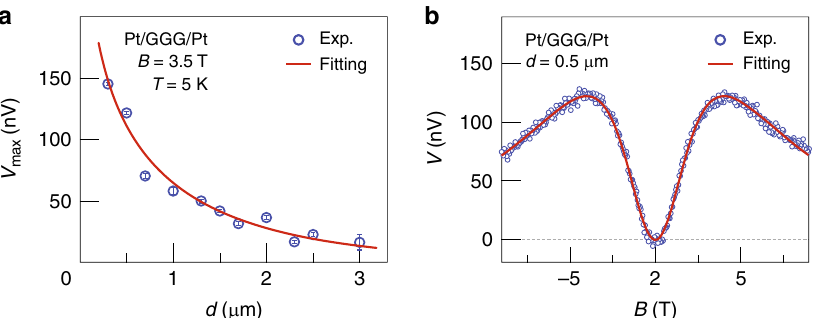
Fig. 4 Comparison with theory. a The experimental results (blue circles) and calculations (solid red line) for V max in Pt/GGG/Pt as a function of the separation d between the Pt contacts and an applied current of 100 μ A. We obtain V max by a cos 2 θ fi t to the magnetic fi eld angle θ dependence of V at B = 3.5 T and T = 5 K. By using Eq. (1), the spin diffusion length λ GGG = 1.82 ± 0.19 µ m. The error bars represent the 68% con fi dence level (±s.d.). b The experimental results (blue circles) and calculation (solid red line) of the B dependence of the nonlocal V for Pt/GGG/Pt for | B | < 9 T. The experimental data shown in b are the same as those shown in